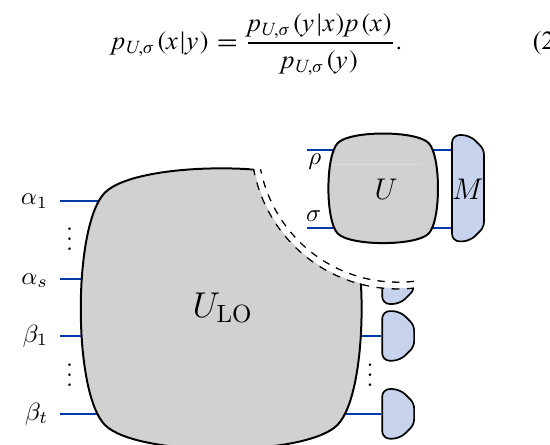
FIG. 1. A scheme for discrimination of multiple coherent states using linear optics and photon detection. The input ensem- ble is made of s -mode coherent states of unknown